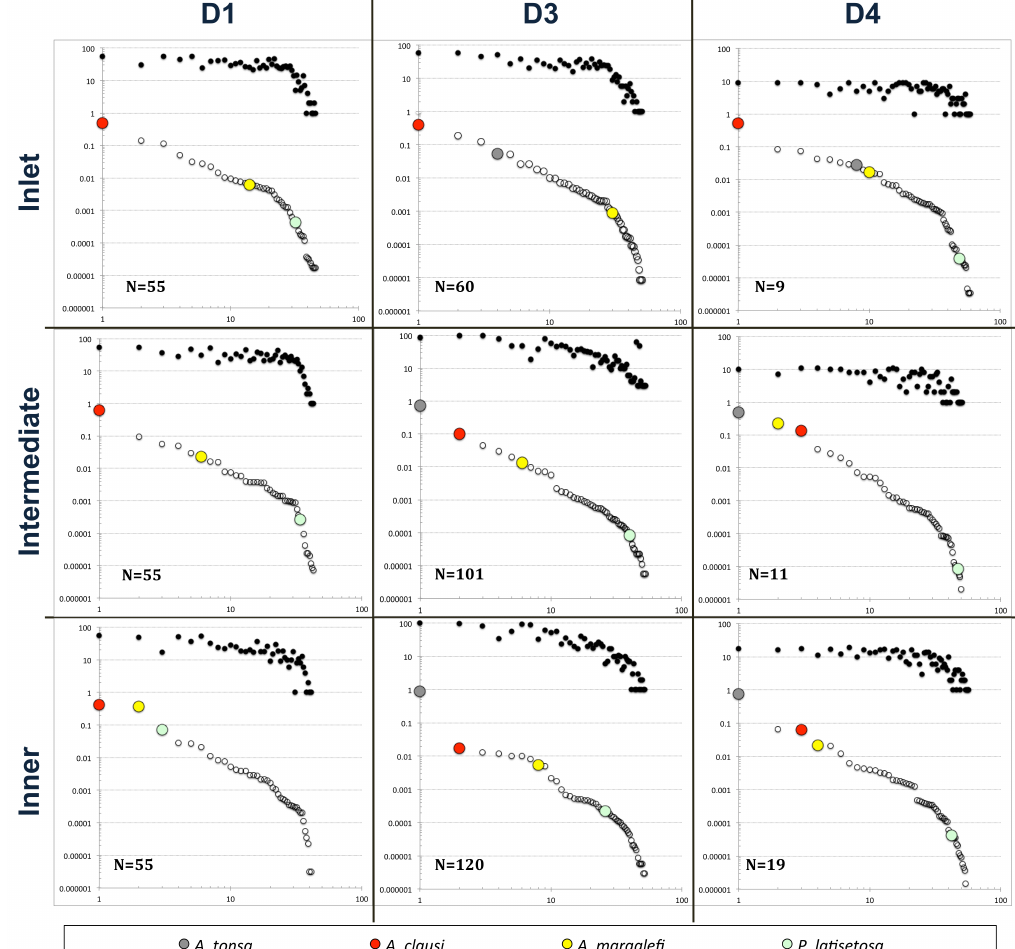
Figure 9. Rank abundance distribution (RAD) and occurrence of the zooplankton community of the Venice lagoon during the period of study (decade D1: 1975–1985, from data set DS1; decade D3: 1995–2005, from data set DS3; and recent period D4: 2005–2017, from data set DS4). The samples were lumped according to the three habitat types along a gradient from the mainland to the sea (see text). In every frame, the upper curve gives the ranked occurrence of each species in the lumped N samples; the Acartia species’s relative ranks are highlighted along the lower RAD